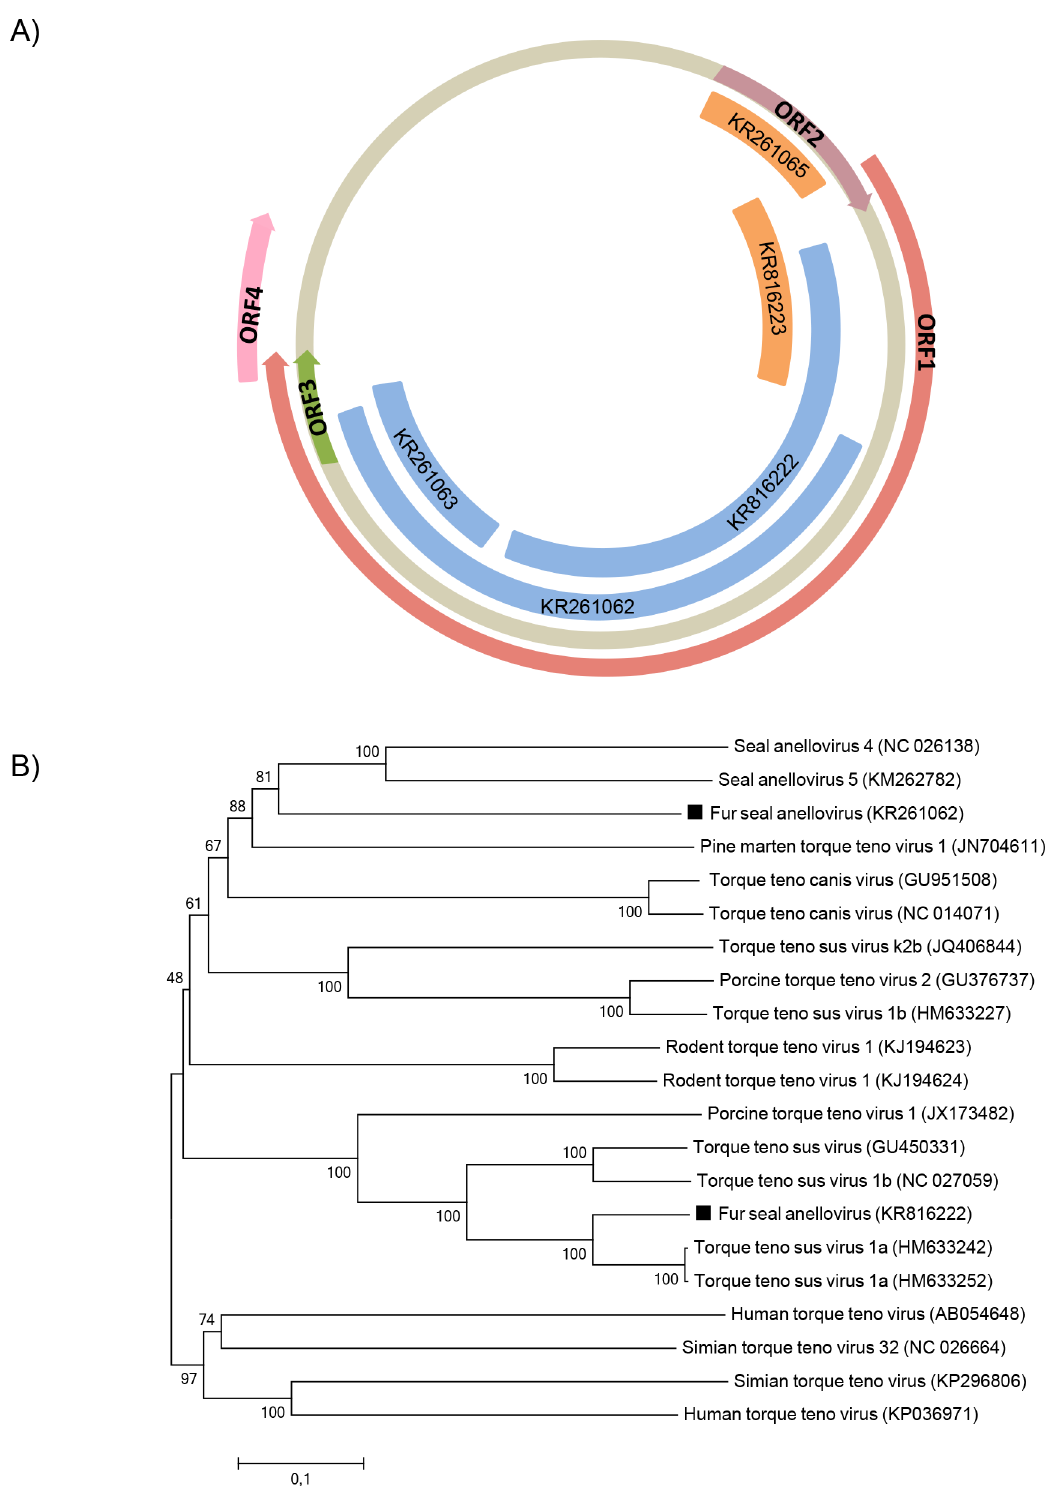
Fig 3. Phylogenetic analysis of fur seal anellovirus. (A) Schematic representation of the genome of anelloviruses using as example the torque teno virus (~3.8 kb). The blue bars represent the contigs from South American fur seal and the orange bars represent the contigs from Subantarctic fur seal. (B) Neighbor-joining phylogenetic tree based on the alignment of partial amino acid sequences (233 aa) from the ORF1 of 21 anelloviruses. Human and simian torque teno viruses were used as outgroup. The anellovirus sequences from South American fur seal identified in this study are labeled with black squares. The GenBank accession numbers of the viral sequences are shown in